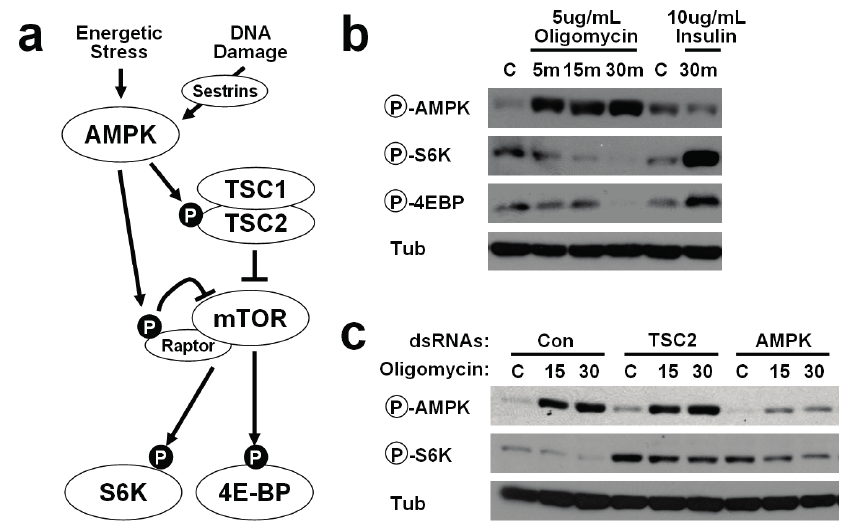
Figure 1. Energy depletion inhibits mTOR complex 1 (mTORC1) signaling through AMP-activated protein kinase (AMPK)-tuberous sclerosis complex (TSC) axis in Drosophila S2 cells. ( a ) Schematic representation of the relationship between AMPK and mTORC1 signaling; ( b ) Energy stress induced by oligomycin, a mitochondrial ATP synthase inhibitor, cause upregulation of AMPK phosphorylation, monitored by anti-phospho AMPK (Thr184, Cell Signaling) antibodies, and downregulation of TOR target gene phosphorylation, monitored by anti-phospho S6K (Thr398, Cell Signaling) and anti-phospho 4EBP (Thr37/Thr46, Cell Signaling) antibodies; ( c ) dsRNA-mediated silencing of TSC2 or AMPK suppressed energy stress-induced downregulation of TOR signaling activity. For detailed experimental conditions, see Experimental